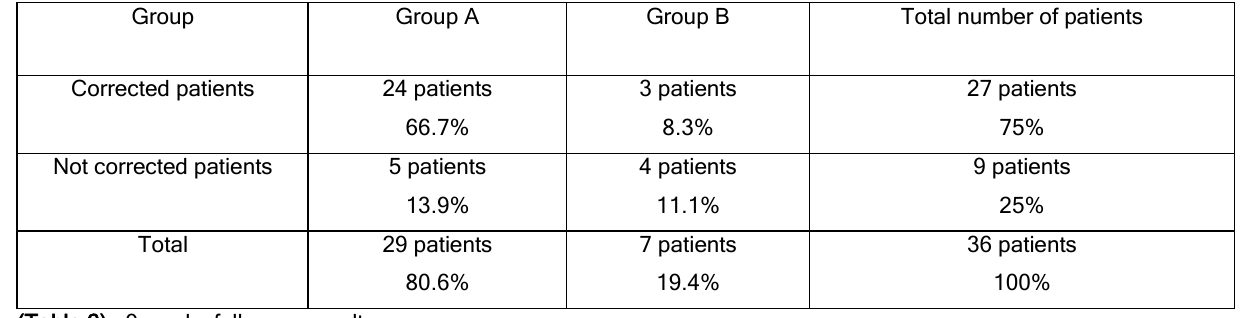
(Table 2): 9 weeks follow up result Group